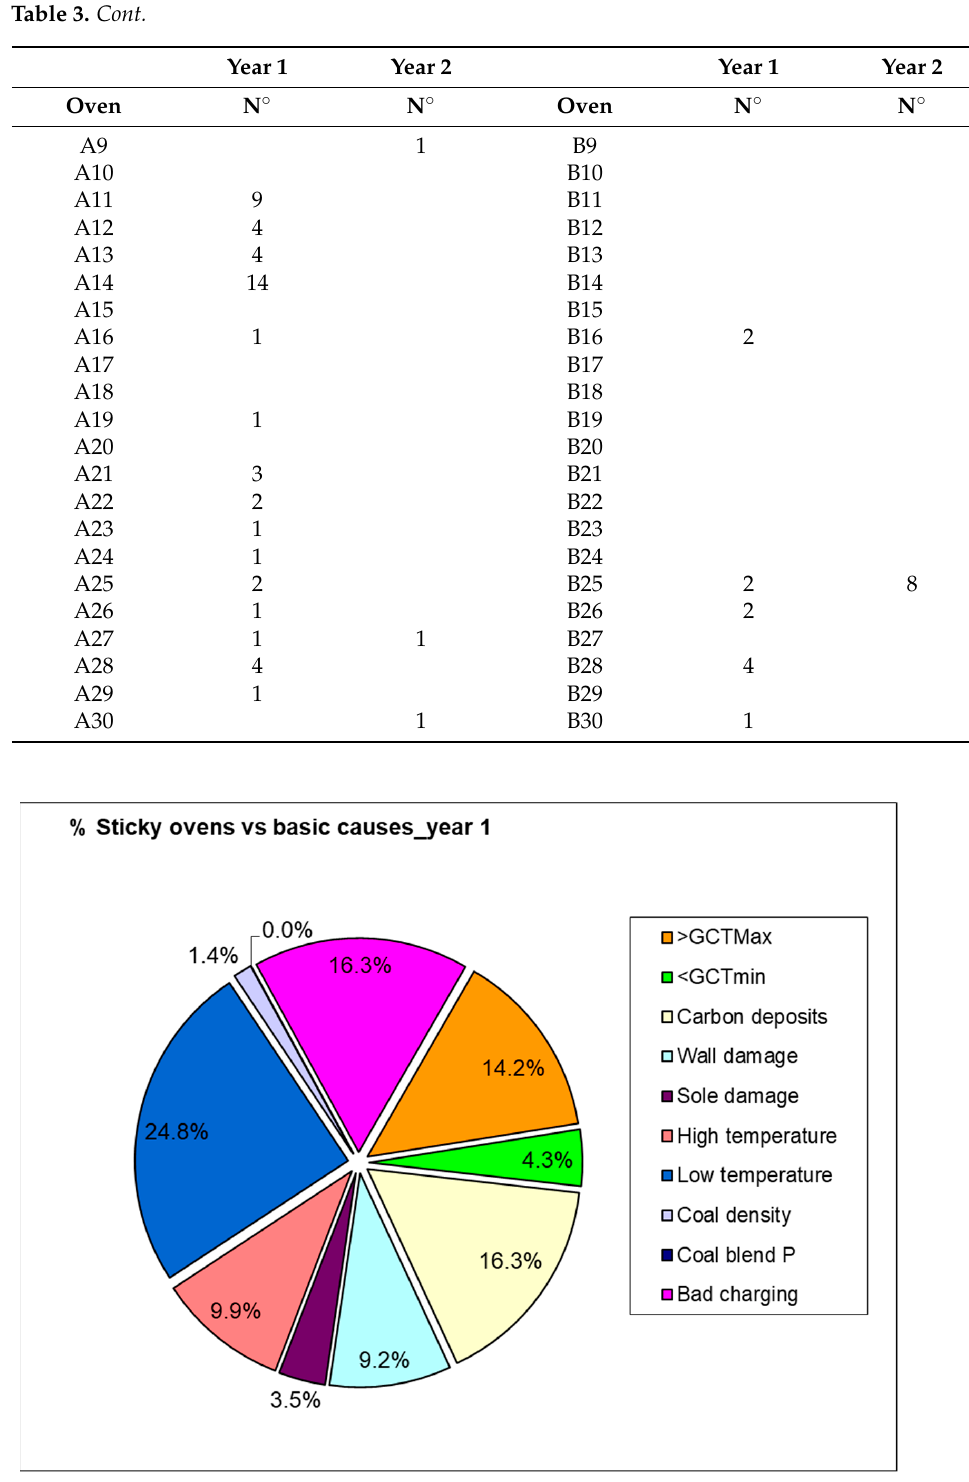
Figure 7. Causes of sticky ovens in the second year. 3.3. Ovens with Damage (Repaired) Table 4 shows the scope of refractory repairs in the ovens of both batteries over a period of two years.